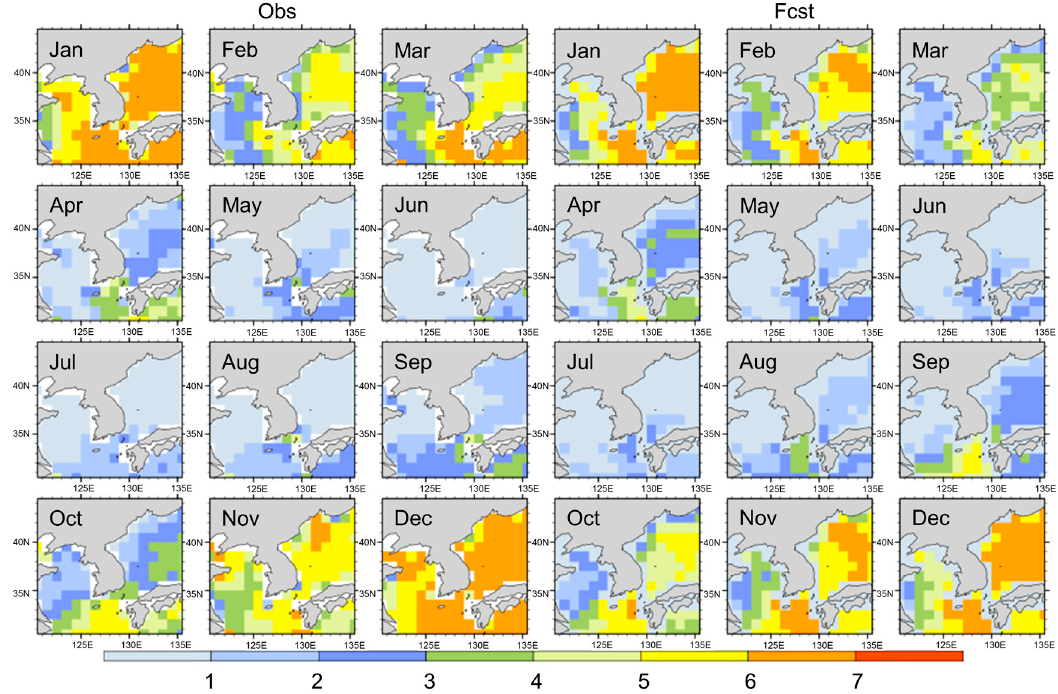
Figure 8. Horizontal distribution of observed (left panels) and forecasted wind power density (right panels). The classes of wind power density at 80 m asl were divided into 7 classes such as 0–250,